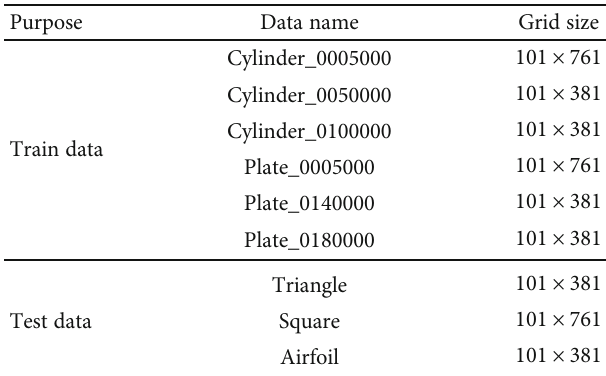
Figure 2: The architecture of the method proposed in this paper, fl ow fi eld data vortex feature identi fi cation process. The preprocessing part preprocesses the data and provides the required input for the network part. The network model part trains a network model for vortex feature recognition. The output of the network model part provides predicted small patches of data for the postprocessing part, and the postprocessing part performs fl ow fi eld reconstruction on the small patches of data. Table 1: Flow fi eld data used in the